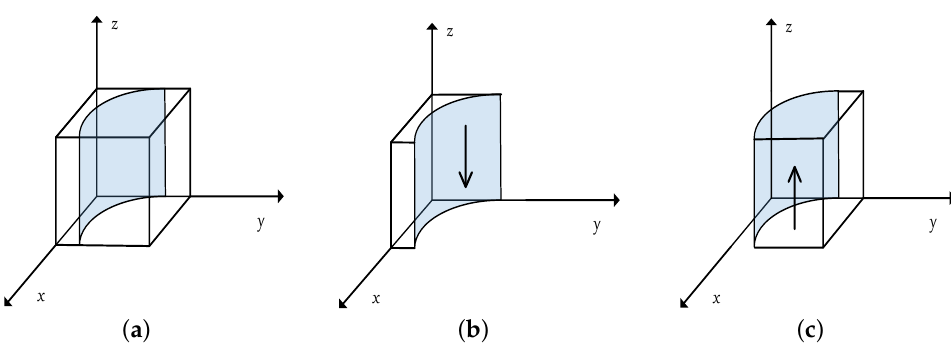
Figure 4. Replication dynamic phase diagram of task requesters: ( a ) x = x 0 ; ( b ) x < x 0 ; ( c ) x > x 0